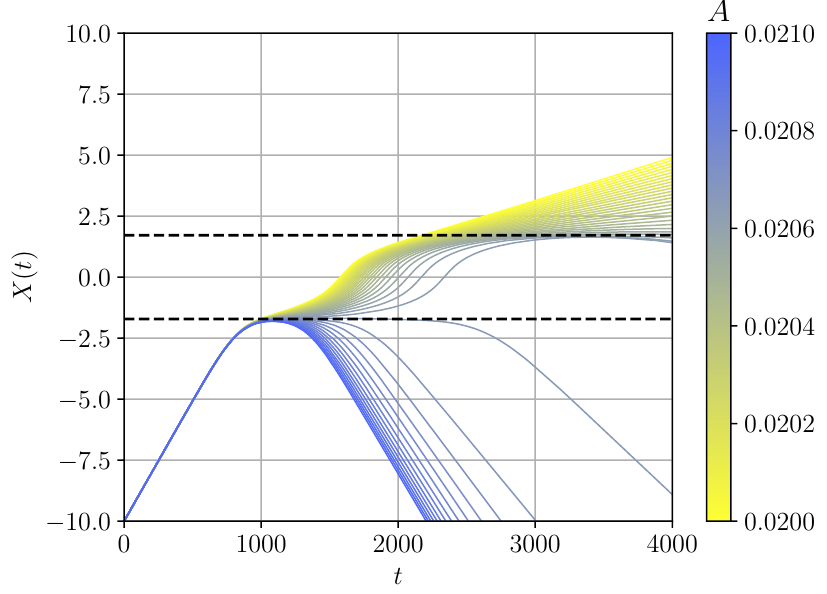
Figure 3 . Antikink’s position as a function of time for several values of the shape mode